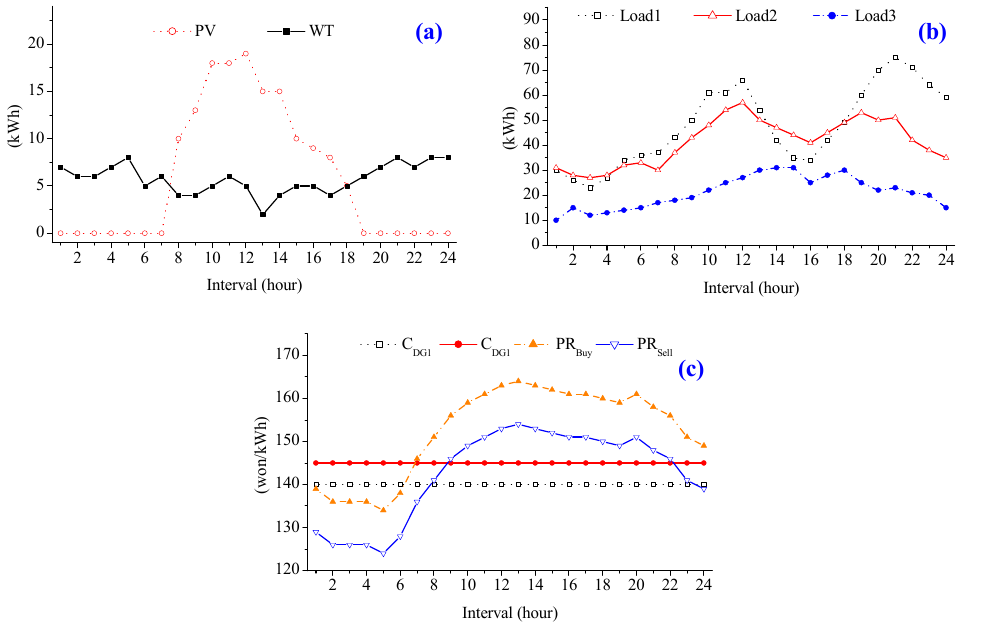
Figure 8. Input data: ( a ) RDG units output; ( b ) load amount; ( c ) market price signals.